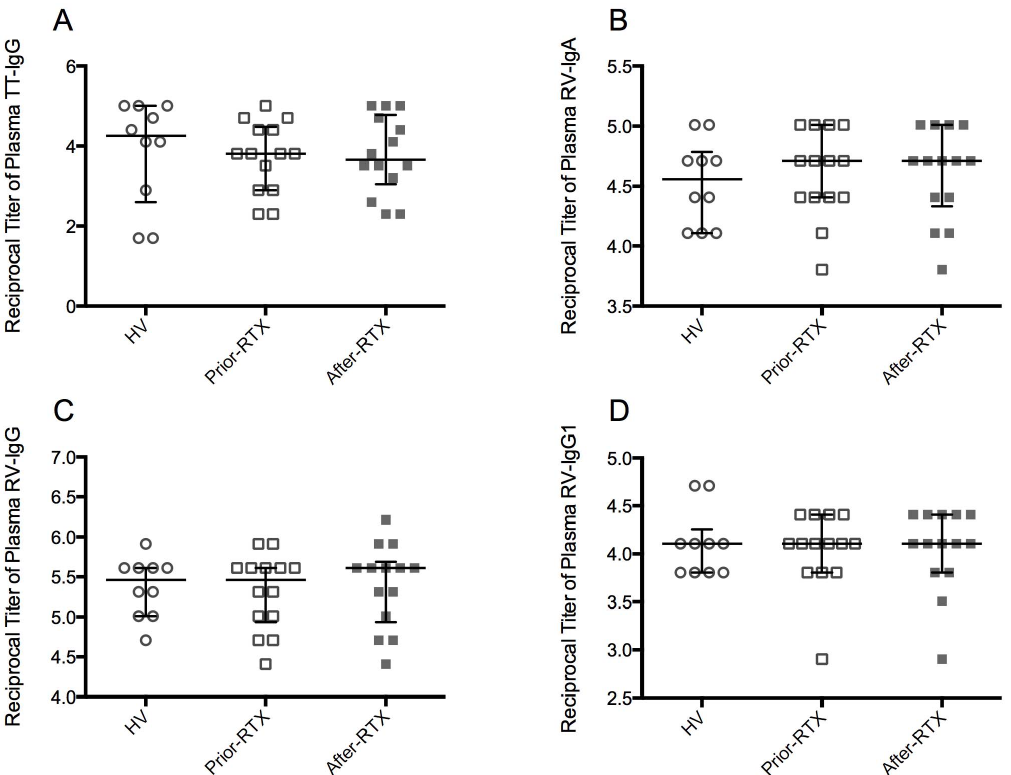
Figure 6. Comparison of RV- and TT-specific immunoglobulins titers in plasma among the study groups. Titers of TT-IgG ( A ), RV-IgA ( B ), RV-IgG ( C ) and RV-IgG 1 ( D ) in plasma determined by ELISA. Solid lines and error bars denote the median and interquartile range, respectively. Differences between HV (n=10) and patients prior-RTX (n=14) were evaluated with Mann–Whitney tests and between patients prior-RTX and patients after-RTX (n=14) with Wilcoxon tests.